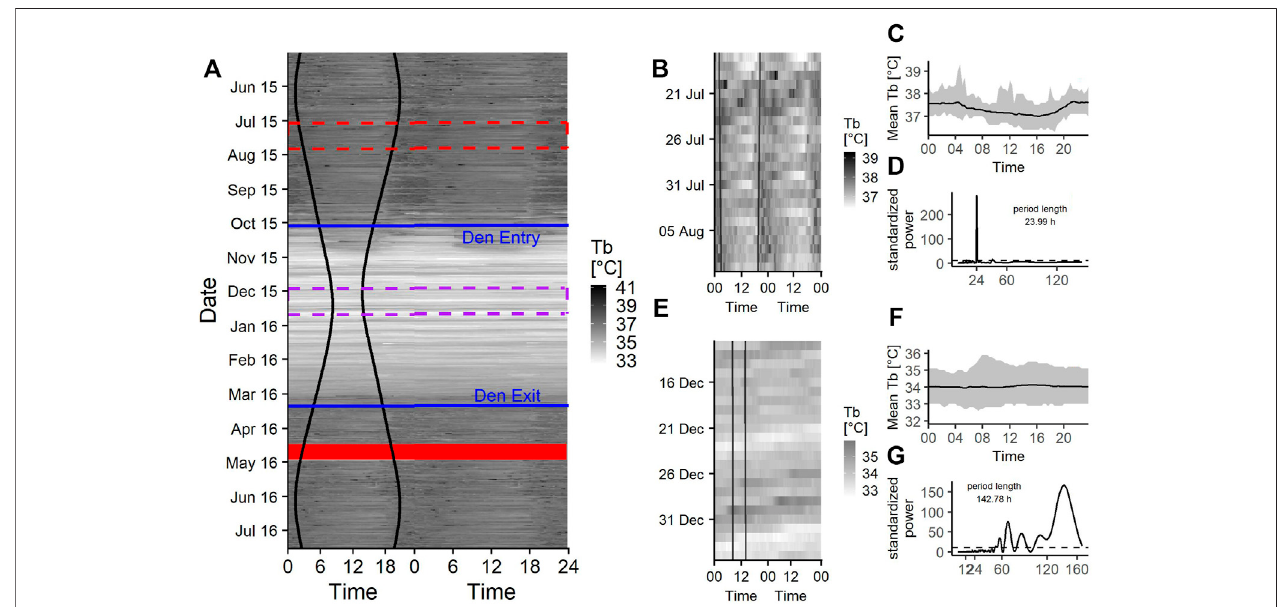
FIGURE 4 | (A) Doupleplot thermogram of the raw body temperature (Tb) data sampled every 20 min of a 7 year old male Brown bear ( Ursus arctos ) with measurementsfrom15thMay2015 – 31stJuly2016.The x axisrepresentsthetimeofdayx(left)andx+1 day(right)frommidnighttomidnightandthe y axisrepresents thetimeoftheyearindays.Bodytemperatureisvisualizedwithacolorgradientfromwhitetoblackwithincreasingbodytemperaturevalues.Sunriseandsunsettimeare representedasblackverticallines,theexcluded14 daysaftercapture(29thApril2016)areshownasaredribbonandthedenentryanddenexitdaysareindicated as blue horizontal lines. The red and purple dashed rectangle are zoom illustrations for a 25-days time span during the active state (B) and hibernation (E) . The mean bodytemperatureduringthe25-daystimespansoveradayareshownin (C) and (F) andthecorrespondingLomb-ScarglePeriodogramsandtheperiodlengthsforthis time span are shown in (D) and (G)